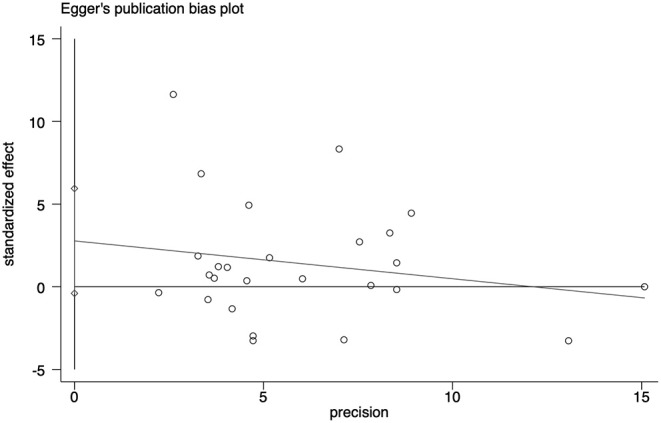
Egger's funnel plot to detect risk of publication bias in the meta-analysis.